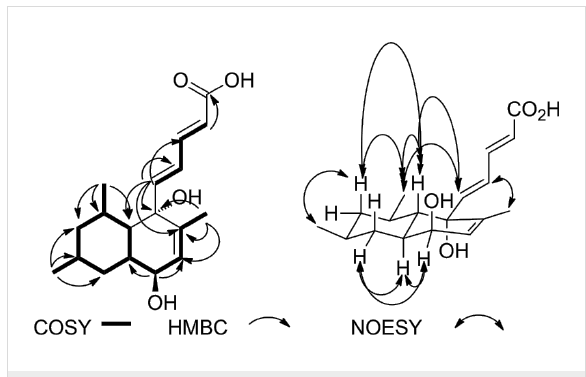
Figure 1: HMBC, COSY and NOESY correlations of compound 1 .